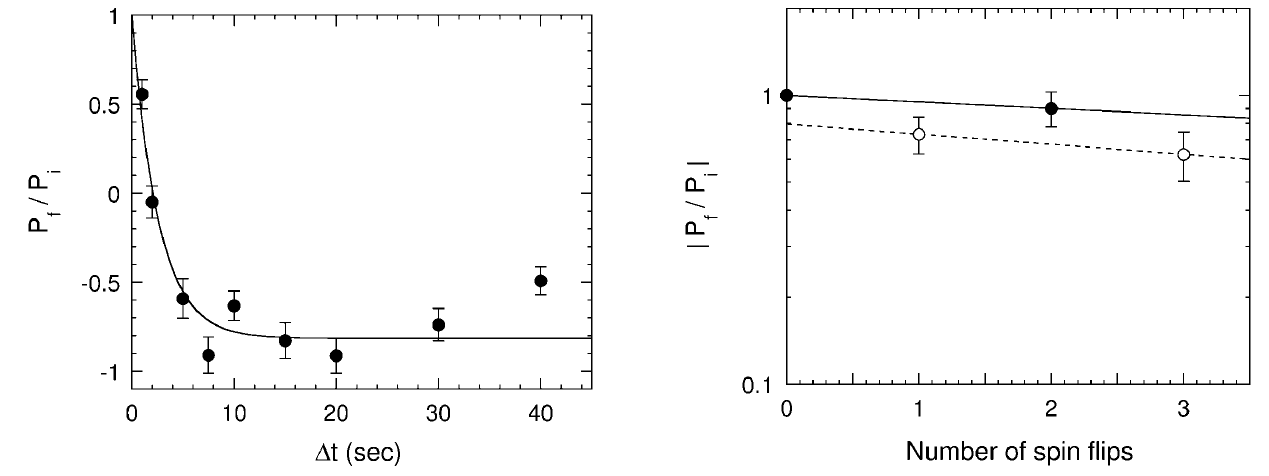
FIG. 3. The ratio of the electron beam’s final polarization to its initial polarization at 669.2 MeV is plotted against the rf dipole’s ramp time D t . Its frequency range D f was 6 1 kHz, R B dl was 0.07 T mm rms. The curve is a fit to the data and its using Eq. (6).